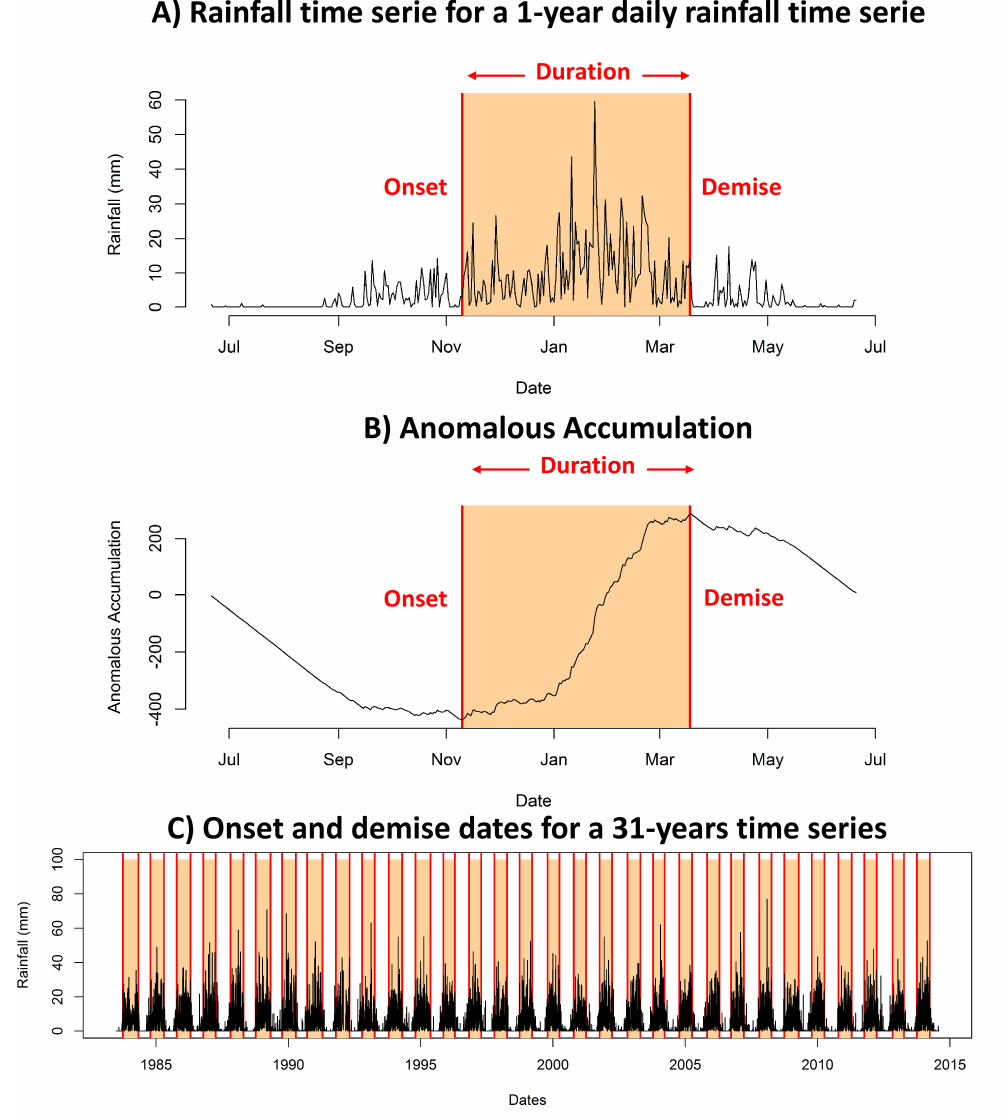
Figure 2. Illustration of the computation of the rainy season temporal metrics based on the method proposed by Liebmann et al. [33]. It includes: ( A ) a one-year daily rainfall time series for a given pixel; ( B ) the corresponding anomalous accumulation time series with identified onset and demise dates; ( C ) the entire (31-year) daily rainfall time series for a given pixel and its corresponding onset and demise